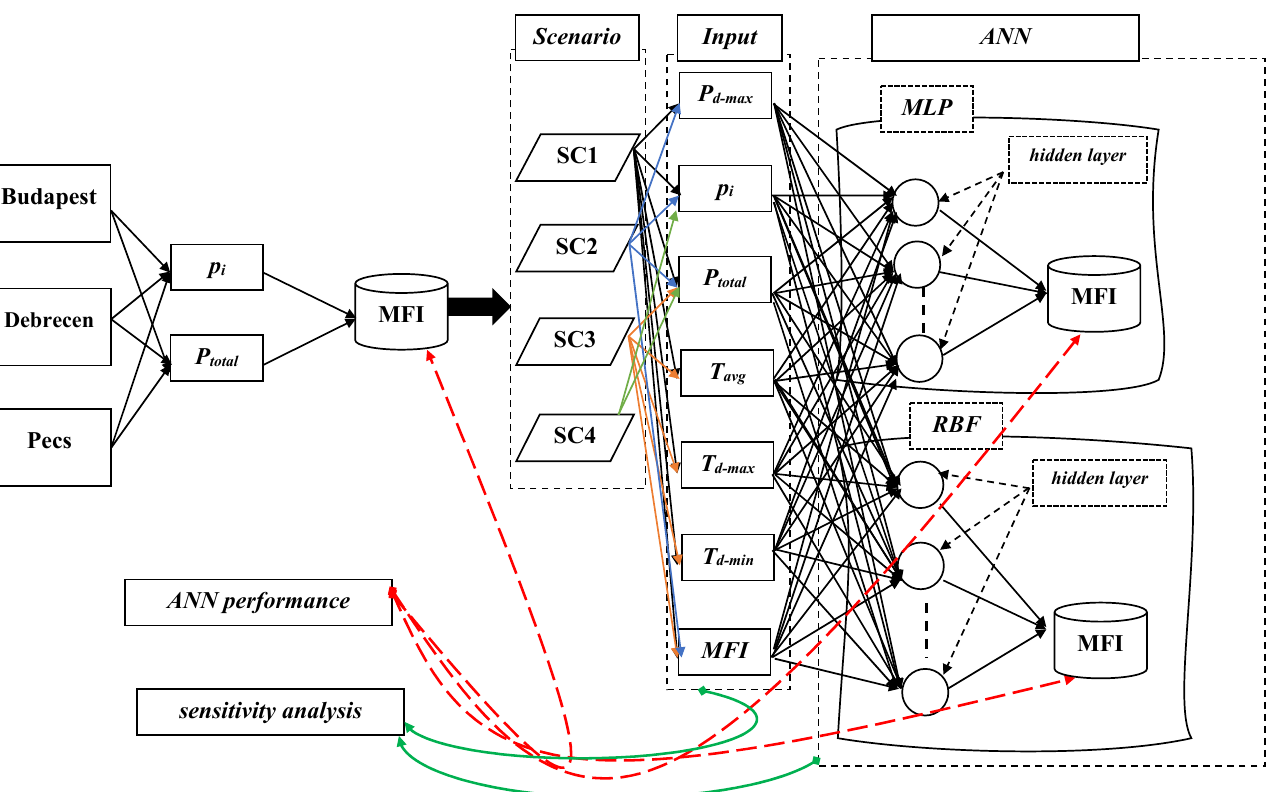
Figure 3. A flowchart depicting the steps adopted in this research: (1) MFI calculation, (2) Scenarios, (3) ANN modeling, (4) ANN performance, (5) sensitivity analysis.